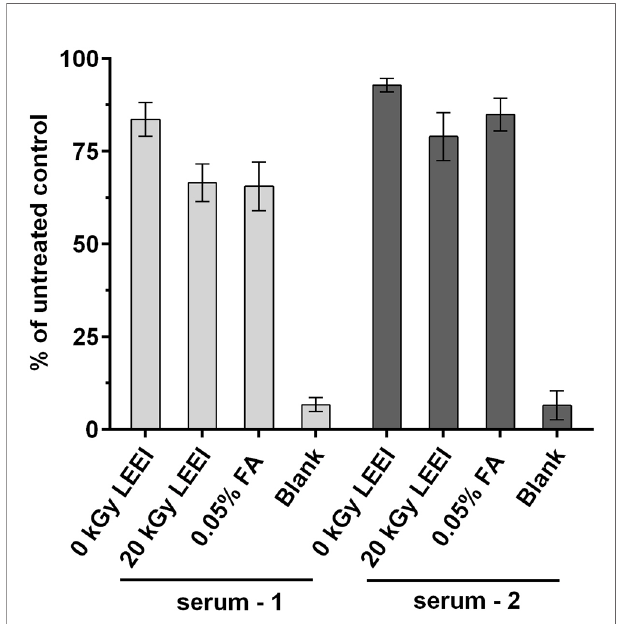
FIGURE 2 | Antigenicity of inactivated TBEV samples. Virus inactivation process was performed either with 20 kGy LEEI or with 0.05% formaldehyde (FA). The ELISA was performed with serum from two TBEV immune individuals. Untreated: virus before inactivation; 0 kGy: virus undergoing the LEEI-process without irradiation; blank: dilution buffer. Shown are mean values of three measurements in duplicates ± standard deviations. Statistical analysis was performed using Kruskal-Wallis test and Dunn ’ s test of multiple comparisons. No statistically signi fi cant differences were detected among the groups.